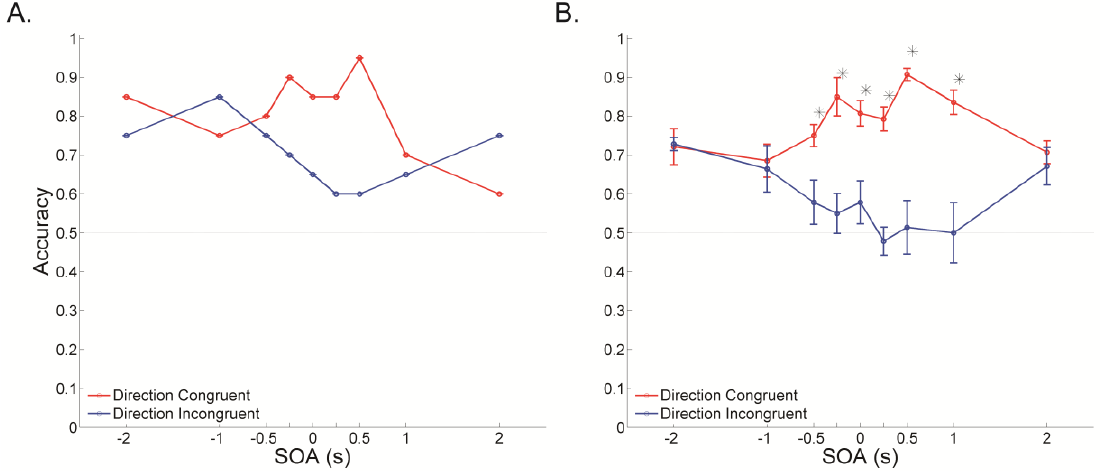
Figure 5. Accuracy as a function of stimulus onset asynchrony (SOA) in direction congruent (red trace) and direction incongruent (blue trace) conditions. For negative SOAs, the tactile stimulus preceded the visual stimulus; for positive SOAs, the tactile stimulus followed the visual stimulus. ( A ) Data obtained from a single subject. ( B ) Data averaged across subjects. The results showed that the degree to which perceived direction of visual motion was biased toward that of tactile motion peaked when SOA was close to zero. (*: p < 0.05 between the direction congruent and incongruent